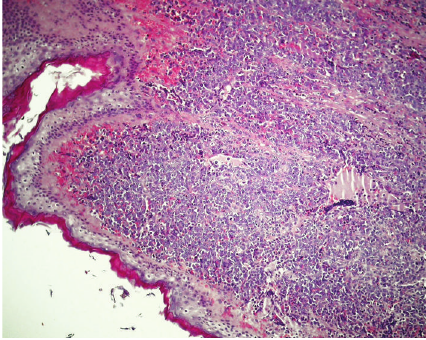
Figure 2: Image of the external auditory canal with epithelial lining and massive cell infiltration of the skin. Haematoxilin-eosine.